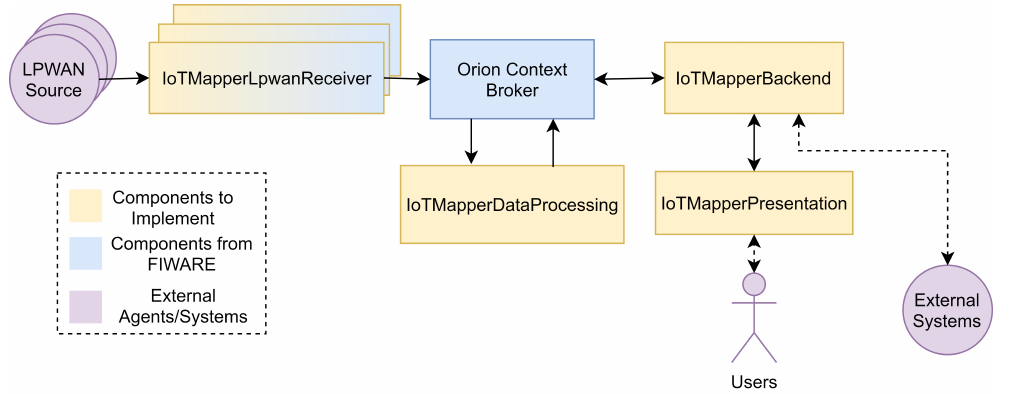
Figure 2. High-level view of system